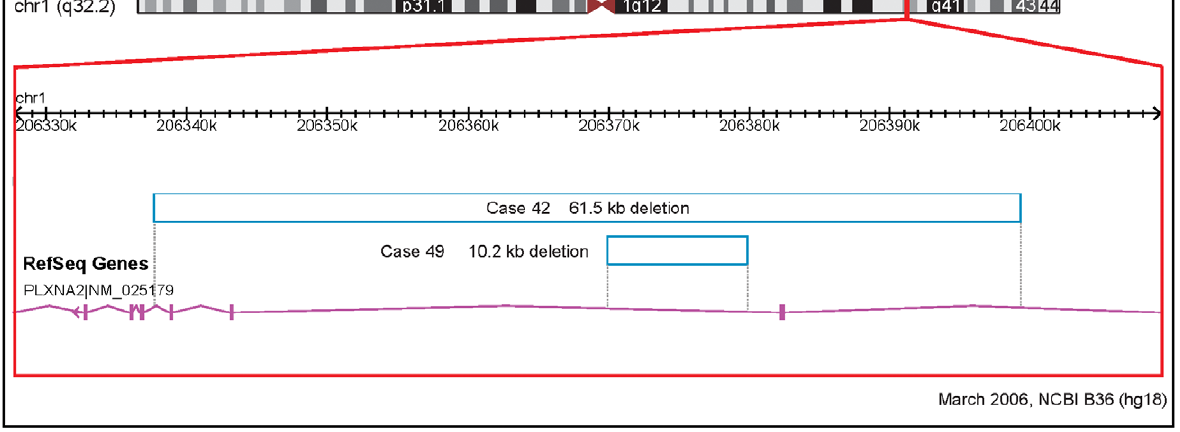
Figure 1. Rare CNVs overlapping novel candidate gene for tetralogy of Fallot: PLXNA2. Solid and open bars represent gains and losses, respectively; genomic parameters from NCBI Build 36.